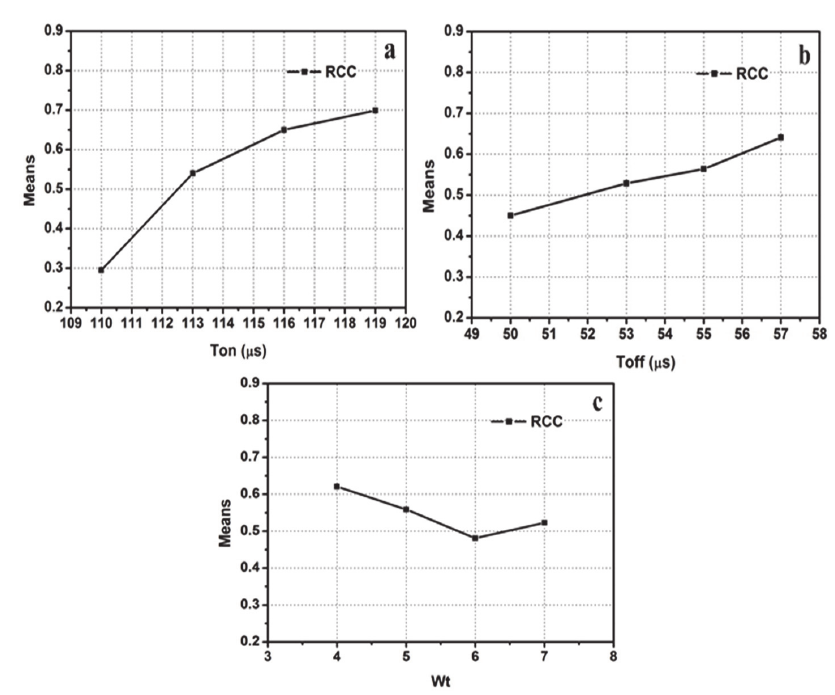
Fig. 6. Main effect plot diagram for RCC and (a) Pulse on time (b) Pulse off time and (c) Wire